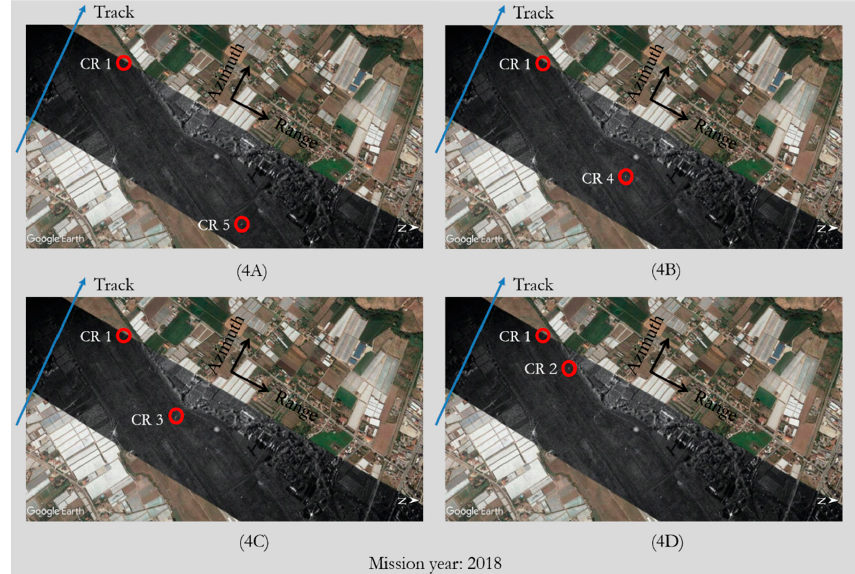
Figure 5. As Figure 2, but relevant to the Experiment 5 (left) and Experiment 6 (right). Number of exploited CRs (red circles): 5. Number of exploited tracks (colored lines): 5. Mission year: 2018 for Experiment 5 and 2019 for Experiment 6. The different flown tracks, which are almost overlapped, Figure 4. As Figure 2, but relevant to the Experiment 4A (top-left), Experiment 4B (top-right), are depicted well separated just for graphical purposes. Figure 4. As Figure 2, but relevant to the Experiment 4A ( A ), Experiment 4B ( B ), Experiment 4C ( C ) Experiment 4C (bottom-left) and Experiment 4D (bottom-right). Number of exploited CRs (red and Experiment 4D ( D ). Number of exploited CRs (red circles): 2. Number of exploited tracks (blue circles): 2. Number of exploited tracks (blue line): 1. Mission year: 2018. line): 1. Mission year: 2018.